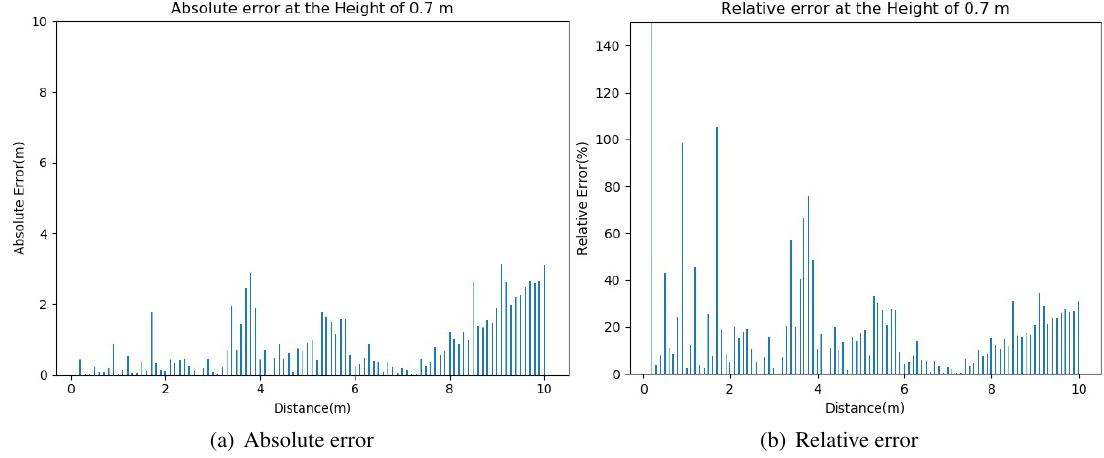
Fig. 5 Errors before and after the RSOA. RSOA, reference signal optimisation